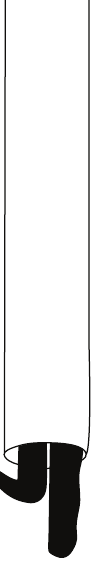
Figure 3: Special hook is passed beside another guide wire through the distal tip of the nail, and then the nail is removed by back extraction of the